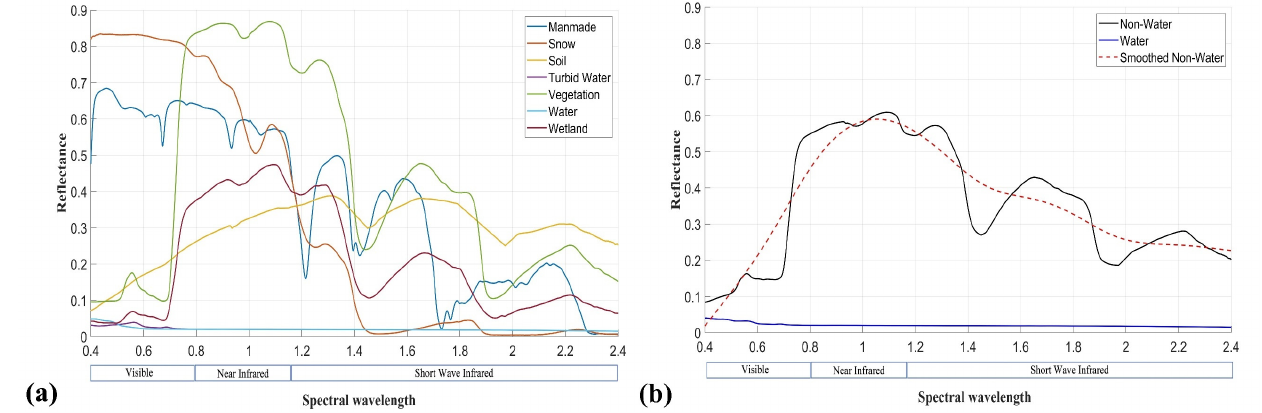
Figure A1. Spectral signature of ( a ) different landcover classes and ( b ) water and non-water (derived from USGS spectral library (splib07)).